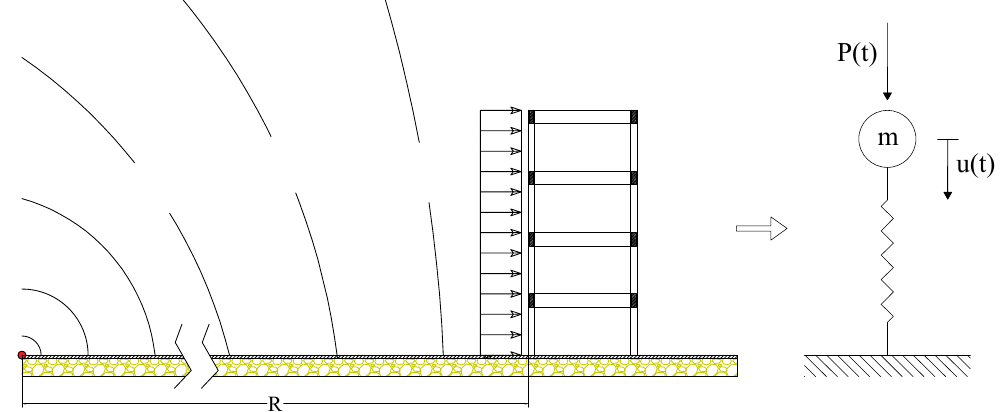
Figure 4. Hemispherical aboveground blast ( left ) and structural model ( right ).